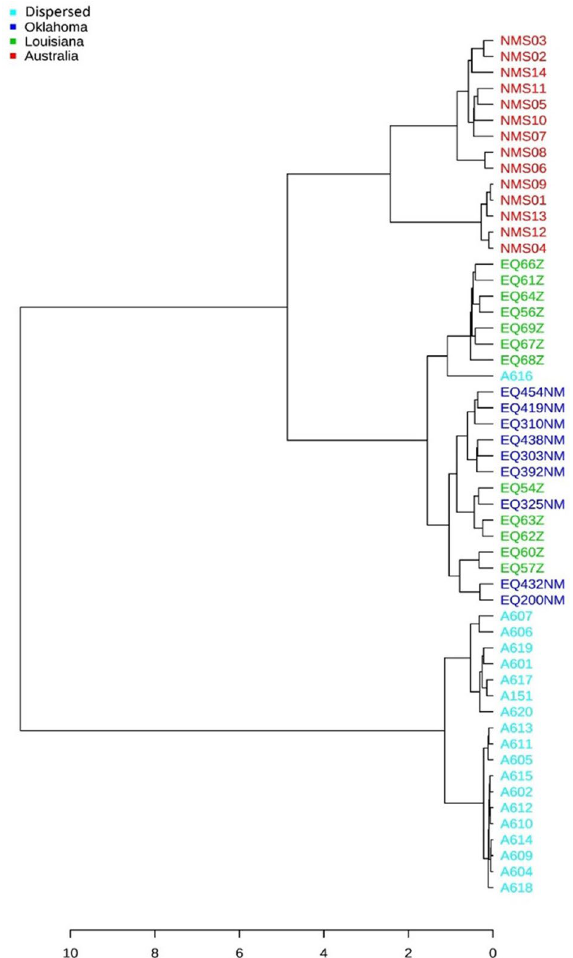
Figure 4. Hierarchical clustering dendrogram drawn at genus level, using Bray–Curtis Index as the distance measure and Ward’s method as the clustering algorithm 24 . Samples from Australia, Oklahoma, Louisiana, and Dispersed animals are color coded based on their geographical